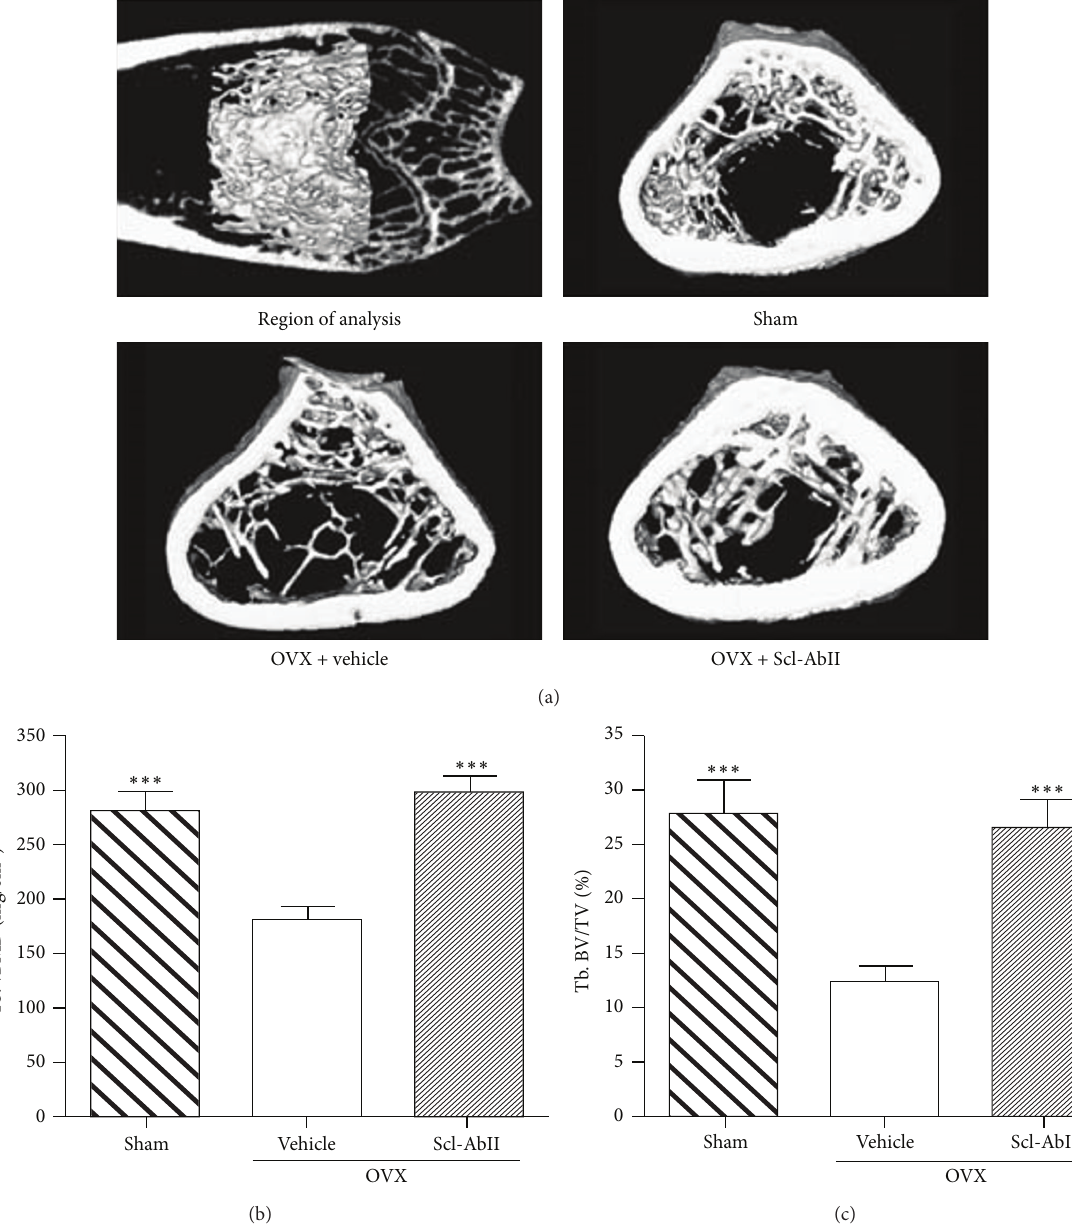
Figure 2: The first in vivo study to test anti-sclerostin antibodies for increasing bone mass involved a rodent model of postmenopausal osteoporosis. Ovariectomised (OVX) rats were treated with 25 mg/kg of sclerostin antibody twice weekly for 5 weeks while sham-operated controls (Sham) were treated with PBS. Treatment with sclerostin antibody reportedly restored trabecular bone volume and bone mineral density (BMD) to comparable levels observed in sham-operated animals. Trabecular volumetric BMD = Tb. vBMD; median trabecular bone volume = Tb. BV/TV. ∗∗∗ 𝑝 < 0.001 versus OVX + vehicle. Reproduced with permission from Li et al.